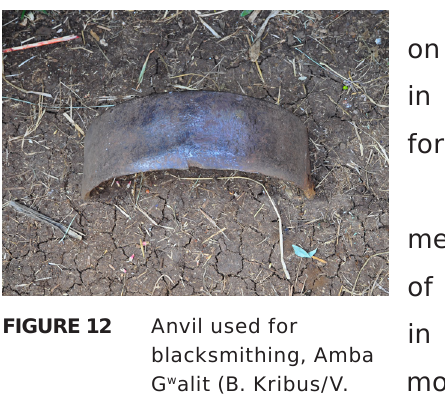
Anvil used for blacksmithing,